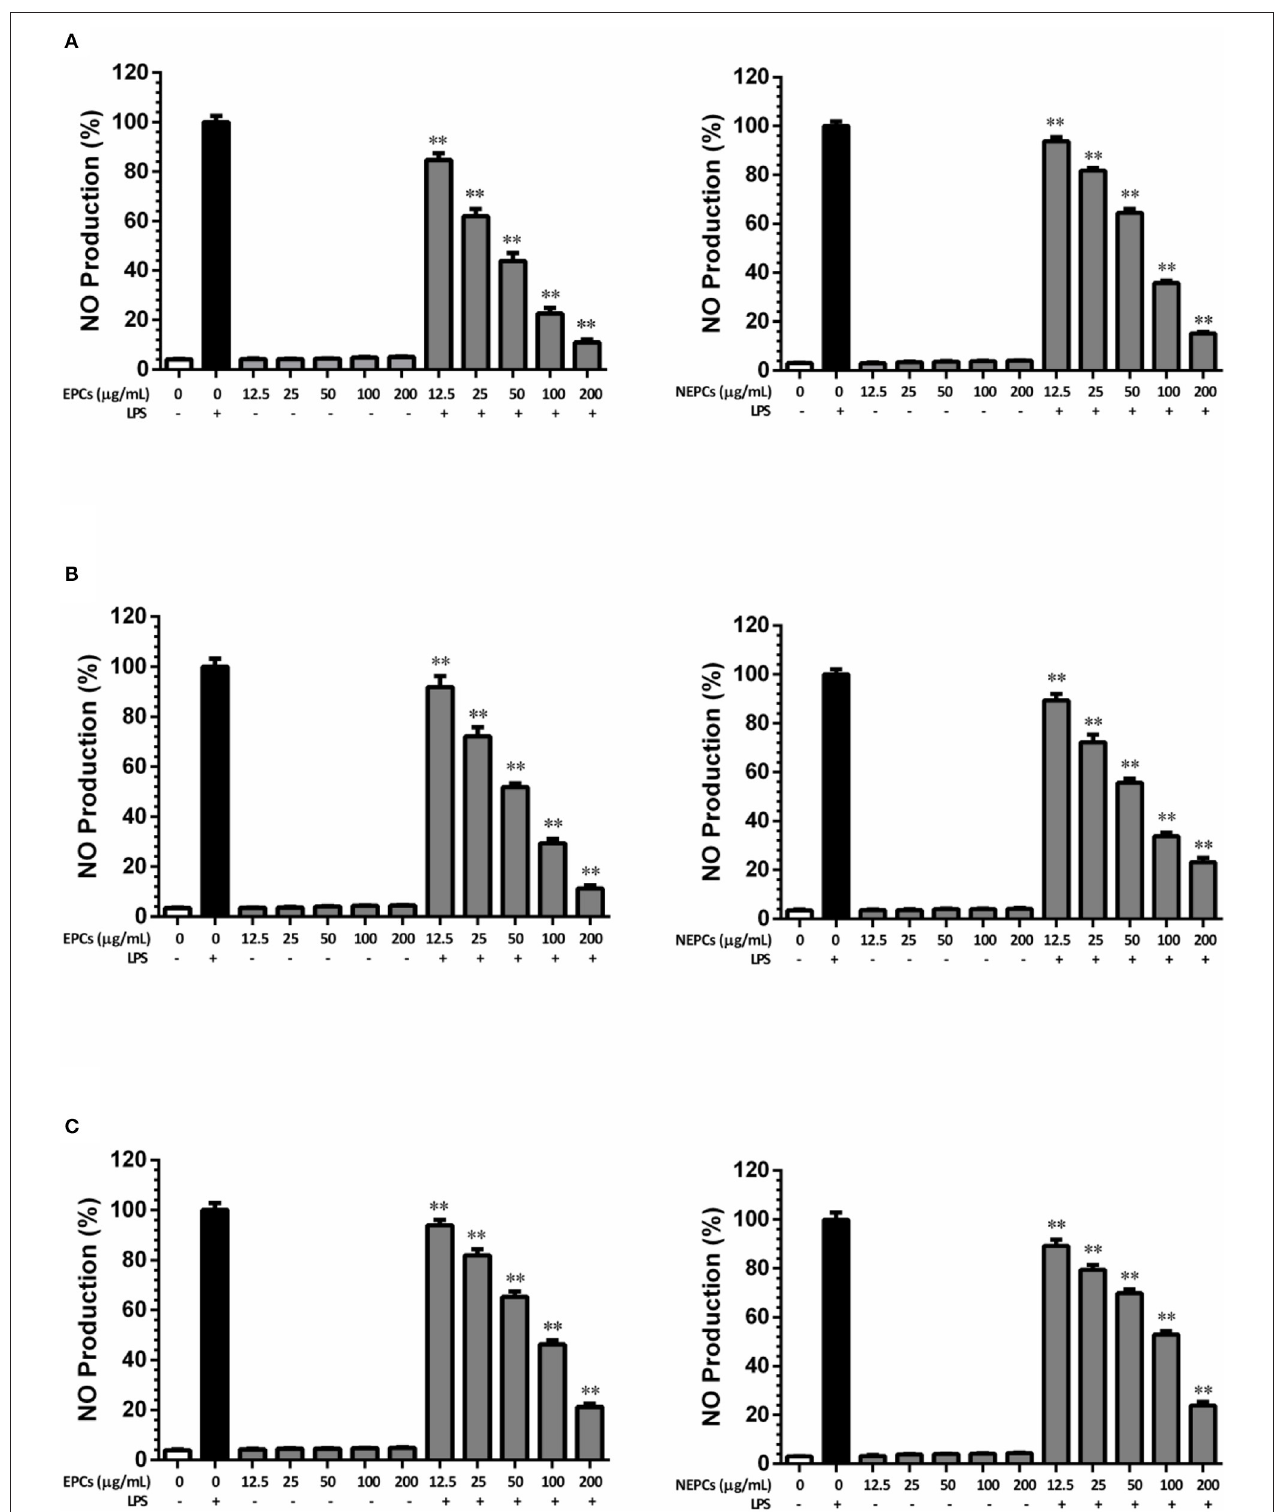
FIGURE 2 | Inhibitory effects of EPCs and NEPCs from L. japonica (A) , U. lactuca (B) , P. tenera (C) on NO production in activated macrophages. Results were expressed as mean ± SD ( n = 6). * p < 0. 05 and ** p < 0.01 indicates statistically differences from LPS-treated group.